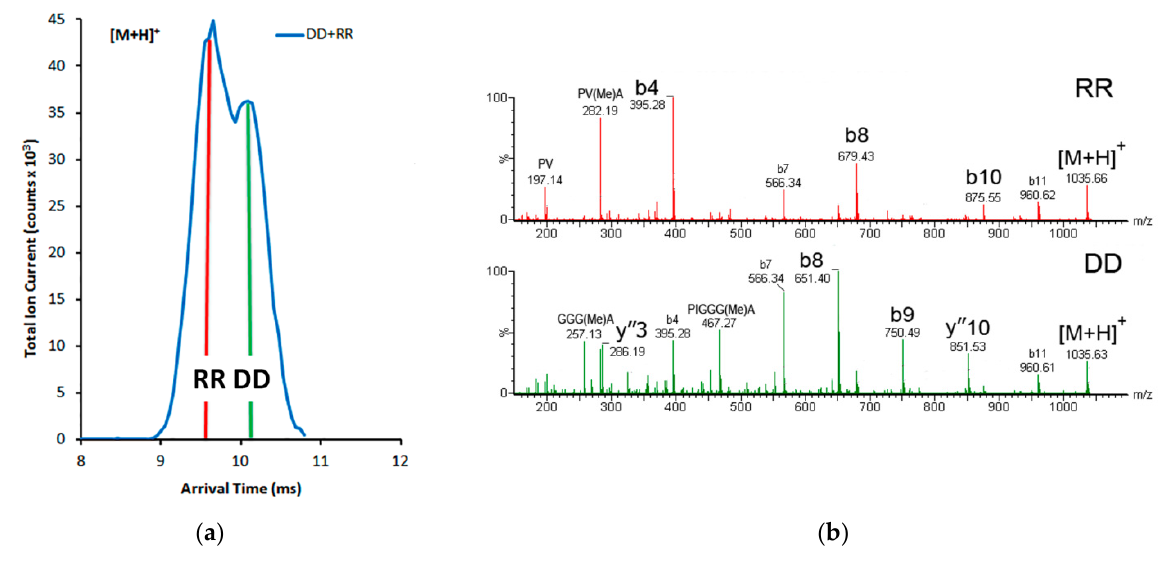
Figure 3. ( a ) The IMS arrival time of the mixture of 150 μ M DD and 50 μ M RR peptides; ( b ) the MS/MS scans of the peak’s sides show the characteristic ions of the different peptides. The left fragment mass spectrum from 9.55 ms has RR peptide fragments; the right fragment mass spectrum from 10.15 ms shows the ions of the DD peptide.